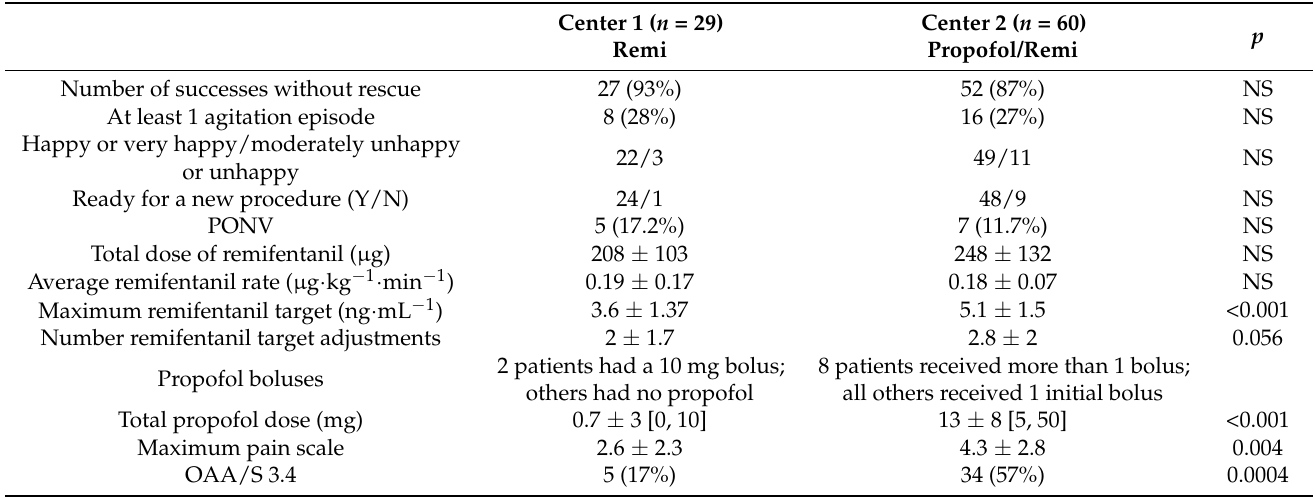
Table 2. Sedation efficacy and drug delivery data. Mean ± standard deviation or number of patients (%).